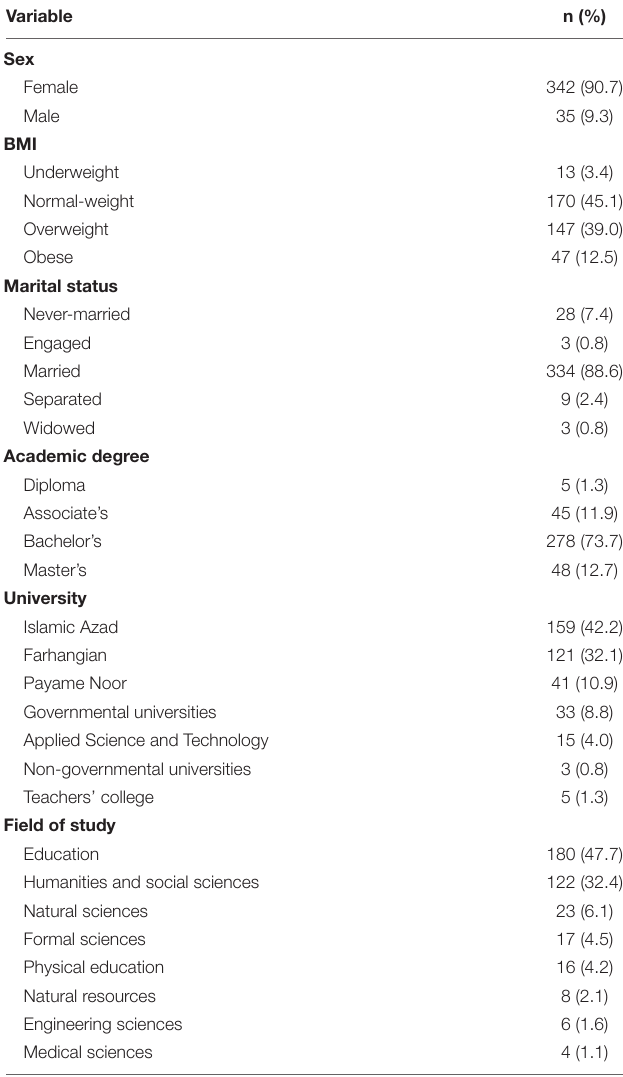
TABLE 1 | Sociodemographic characteristics of the